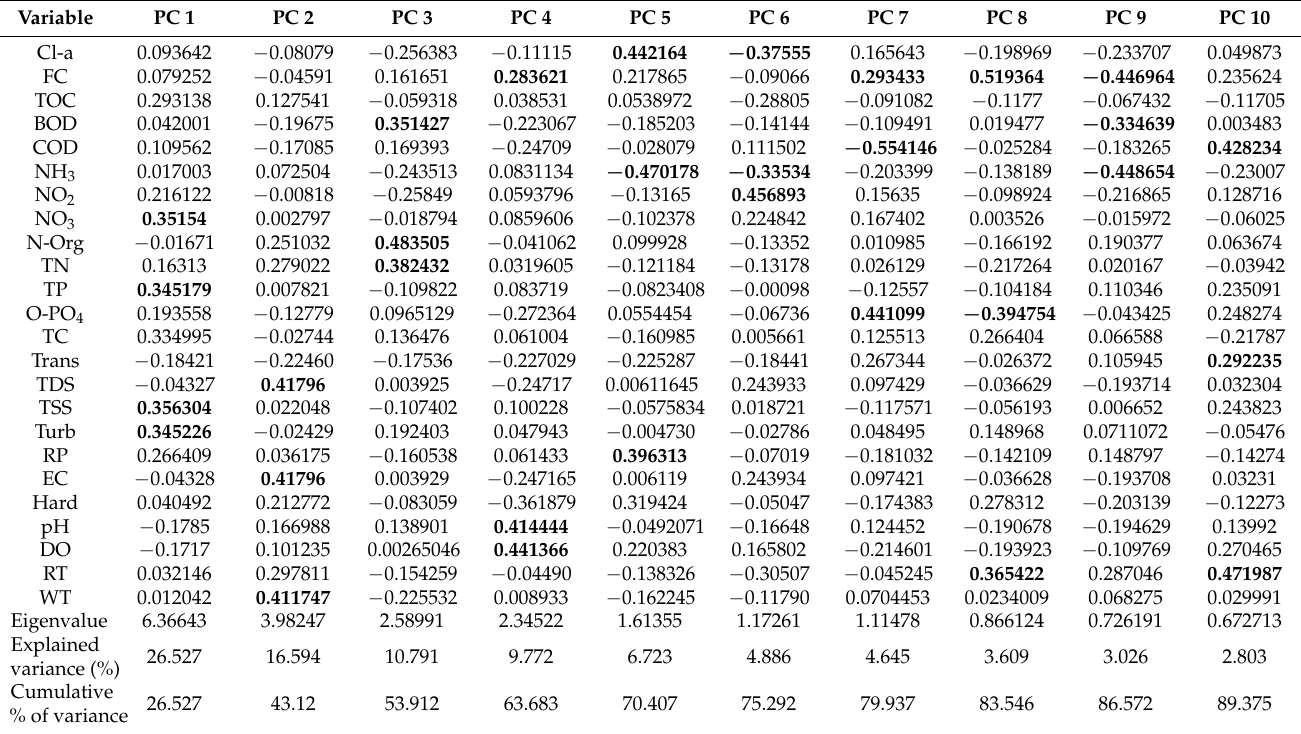
Table 2. Principal component (PC) loadings for the water quality parameters of the ALM